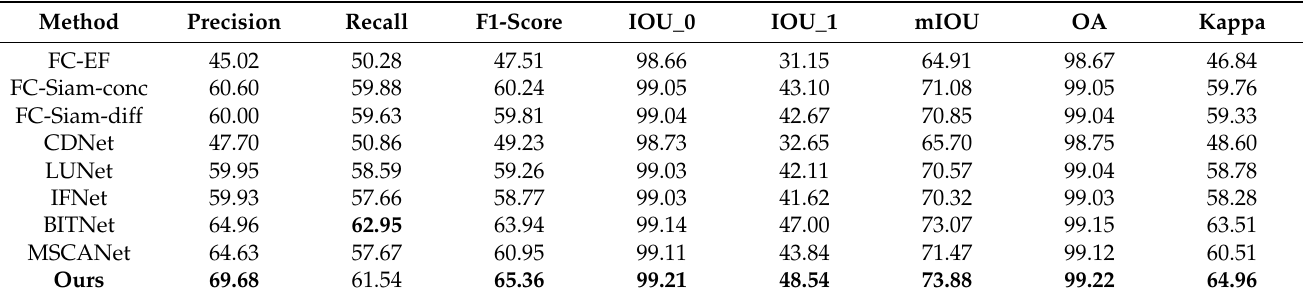
Table 6. Quantitative comparisons of various CD methods from the S2Looking-CD dataset.